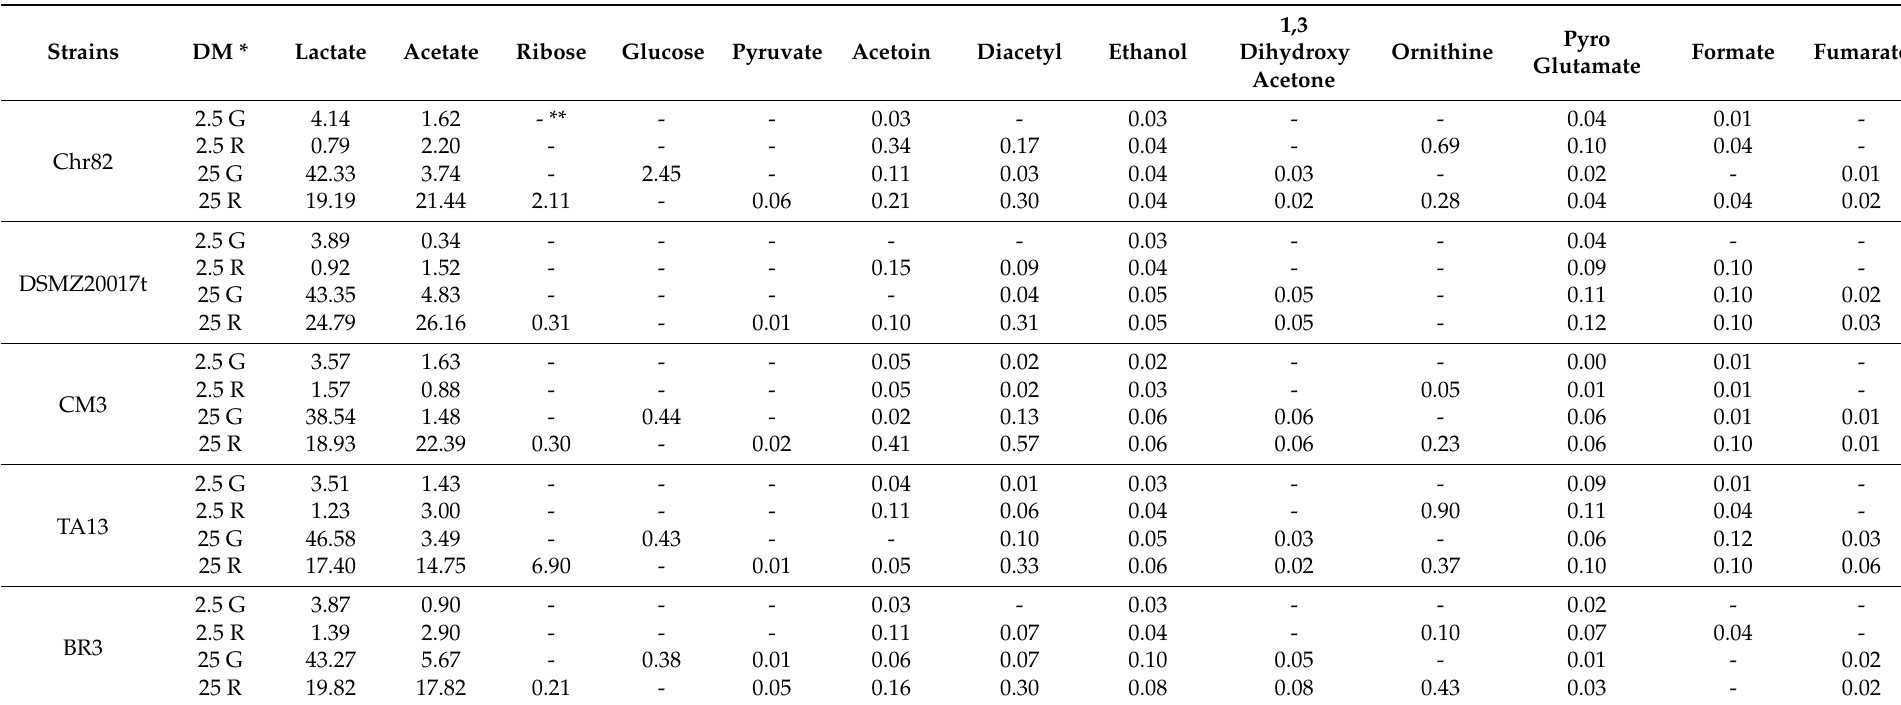
Table 3. Concentration (expressed as mM) of some metabolites detected by 1 H-NMR after 24 h of incubation of the five L. sakei strains in the different